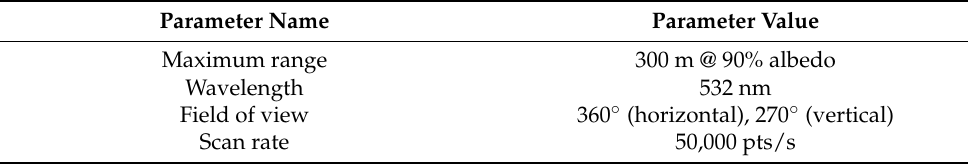
Table 1. Main parameters of Leica ScanStation C5 terrestrial laser